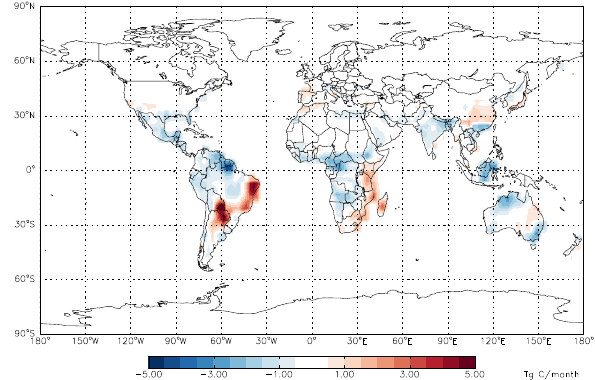
Fig.2. Spatial distribution of difference between terrestrial exchange from CASA and Fig. 2. Spatial distribution of difference between terrestrial ex- change from CASA and fluxes from VEGAS in January 2006 (pos- fluxes from VEGAS in January 2006 (positive values denote the fluxes from VEGAS itive values denote the fluxes from VEGAS are greater than the fluxes from CASA). are greater than the fluxes from CASA)